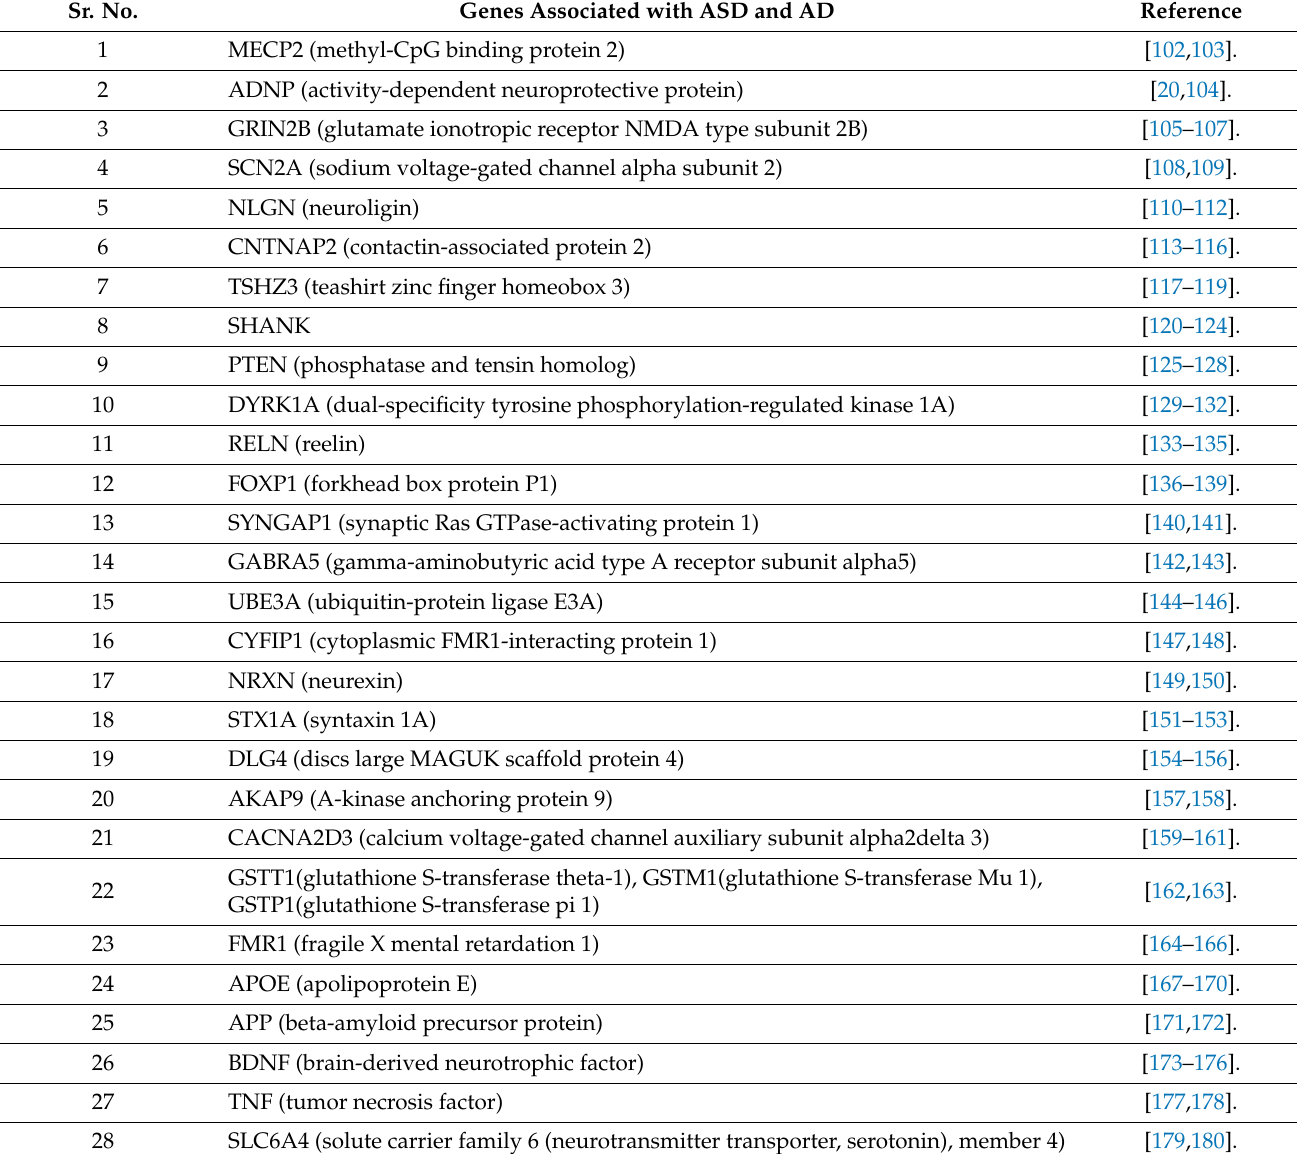
Table 1. Shared genes and factors associated with ASD and